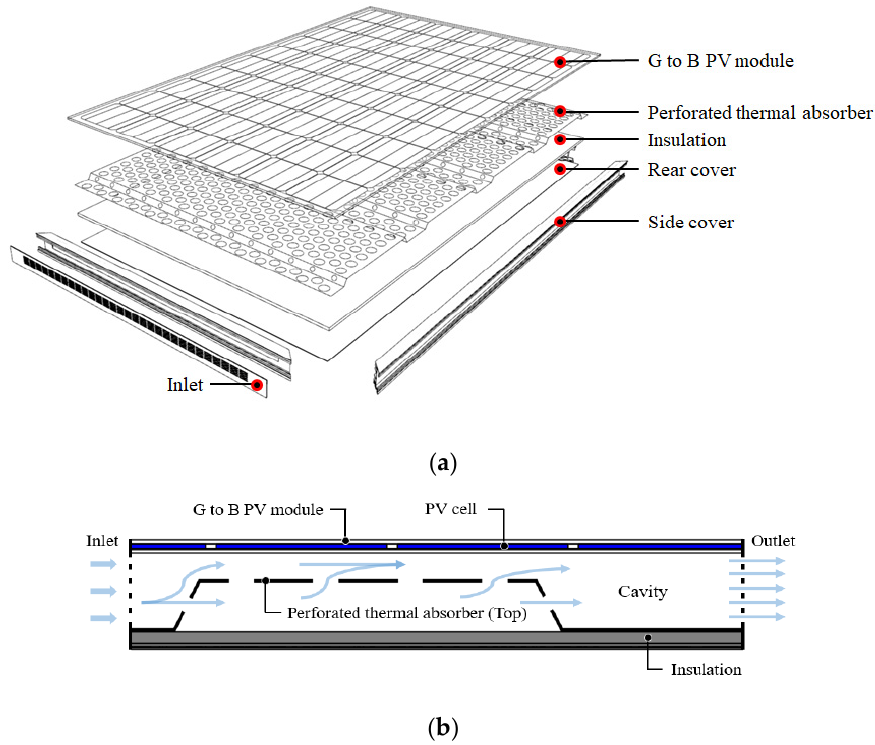
Figure 1. Concept of the air-type PVT collector with perforated baffle: ( a ) 3D blown-up picture and ( b ) cross sectional profile showing air flow direction.